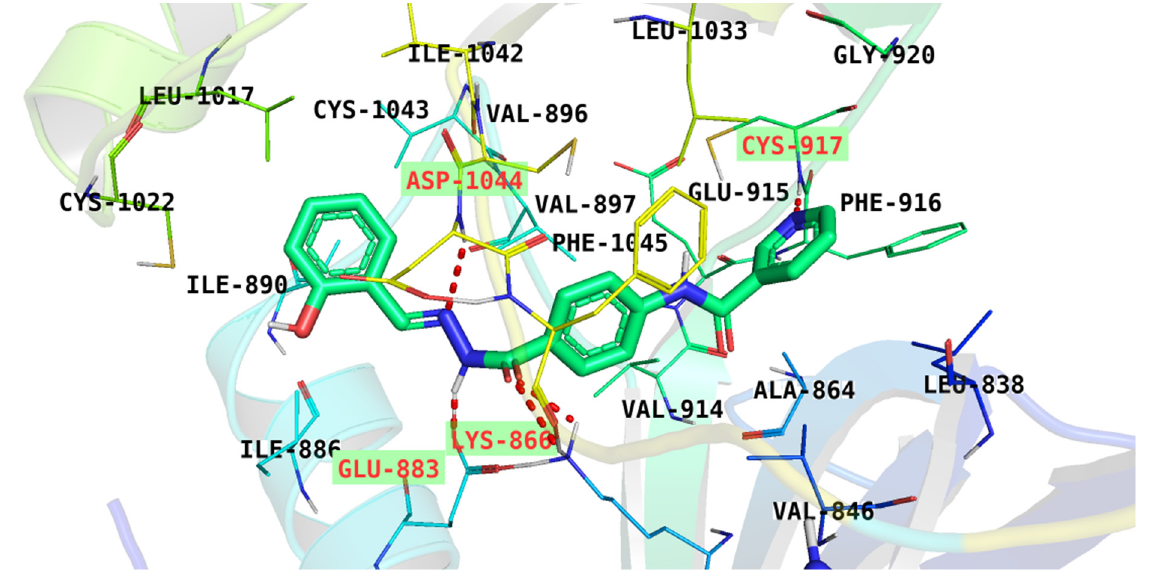
Figure 8. Binding pattern of compound 7 forming five H-bonds with Cys917, Asp1044, Glu883, and Lys886 in addition to many hydrophobic interactions with Phe1045Ile886 and Val897.